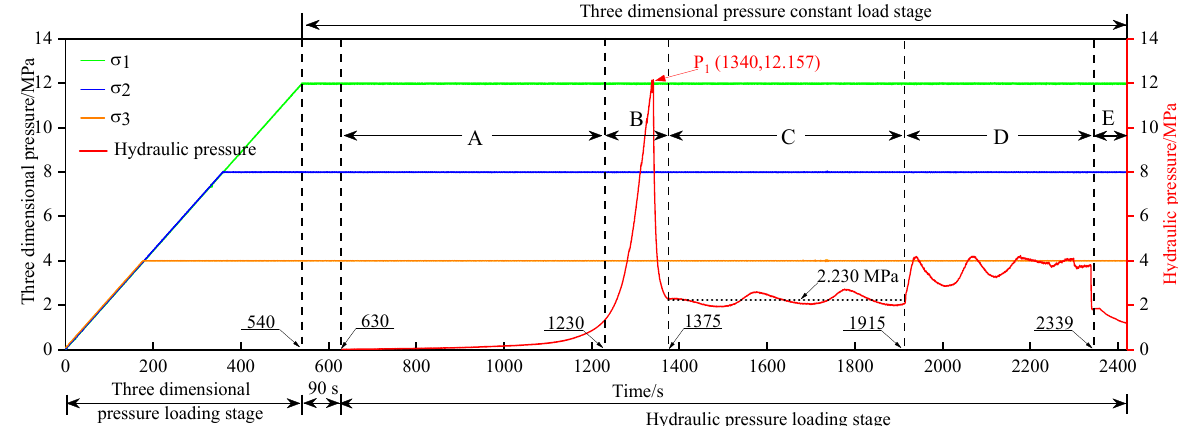
Figure 4. Hydraulic pressure curve and three-dimensional pressure curve during HF experiment. Table 1. Parameters of true triaxial HF experimental